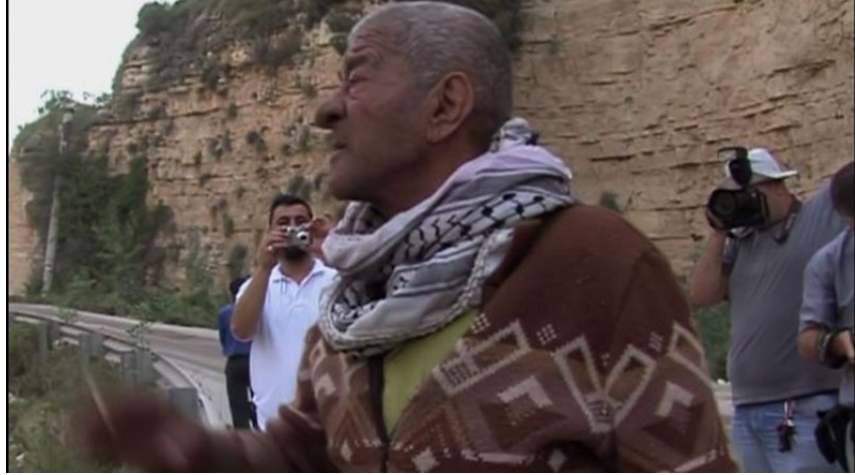
Figure 13 Yousuf right before evacuation, Source: 'Roshmia', Salim Abu-Jabel,